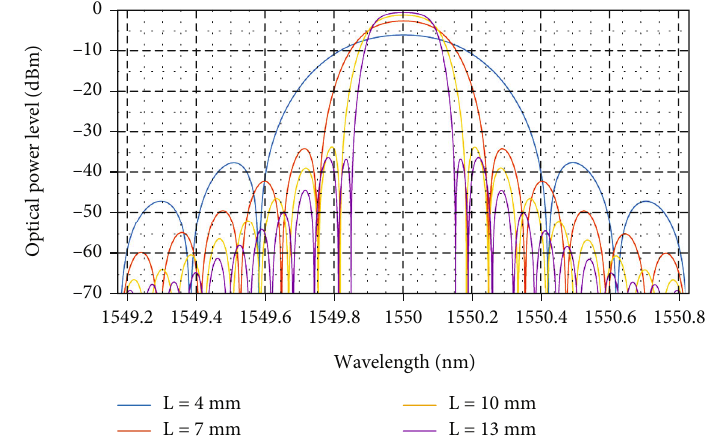
Figure 3: Geometrical shapes of FBG apodization pro fi les.